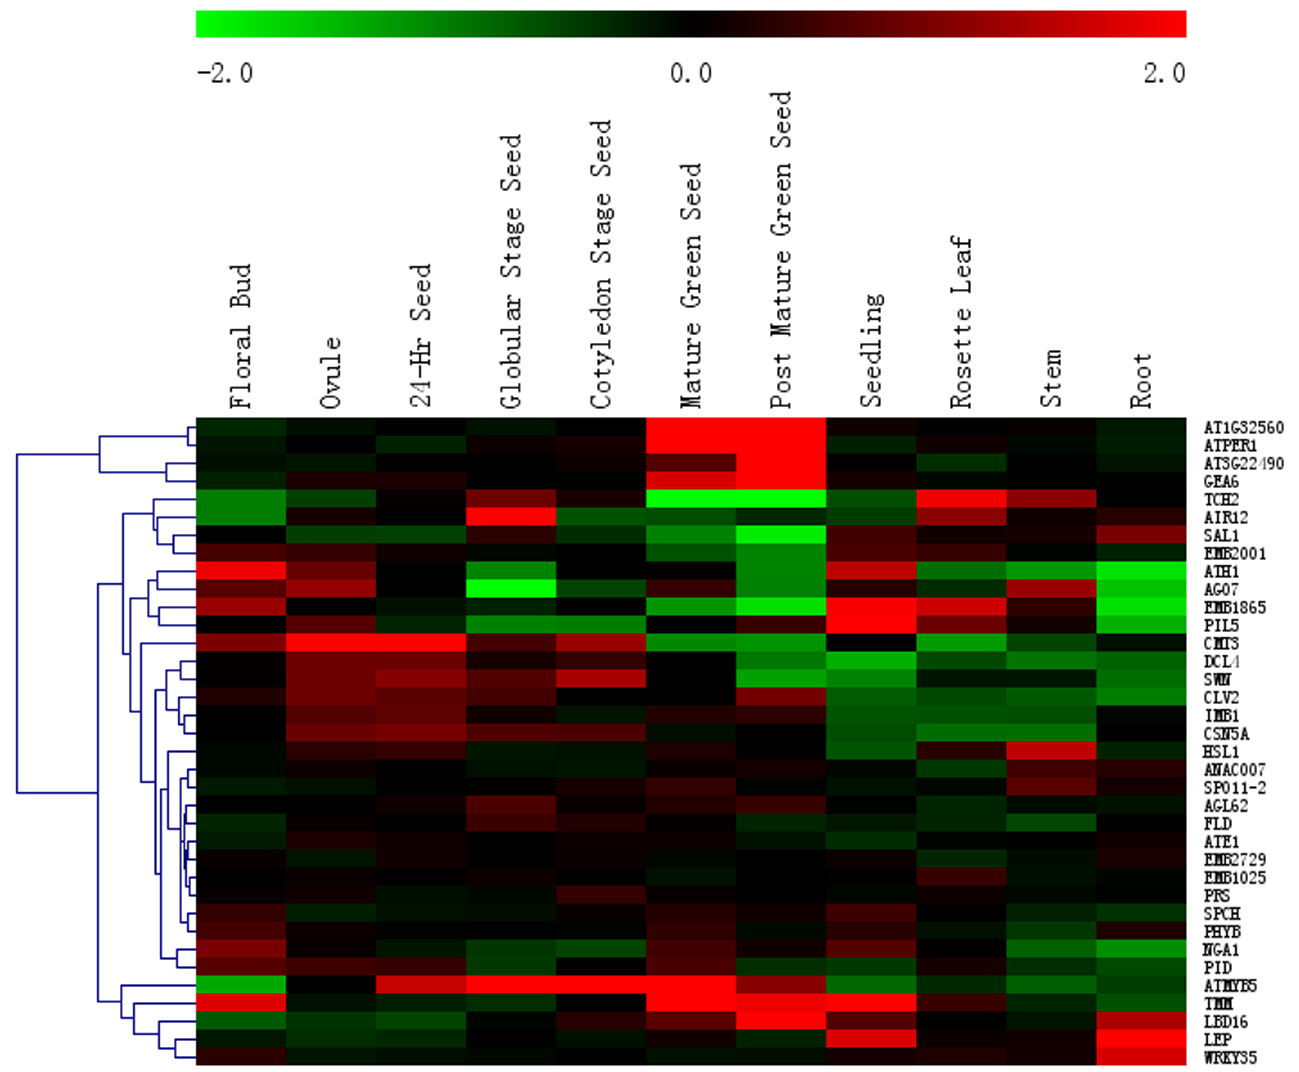
Fig 8. Expression profile of 36 Arabidopsis PEDG orthologs during seed development. Forty sand rice-specific conserved PEDGs and 36 corresponding Arabidopsis genes showed specific probes on the microarray.